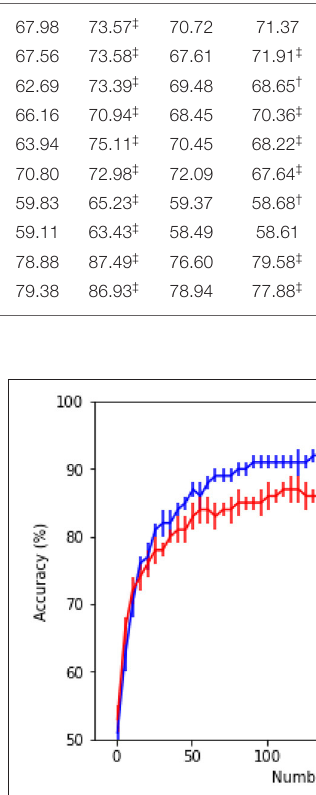
FIGURE 9 | Accuracy vs. number of features for a RF classifier and a combined AF-HAPPE enhancement